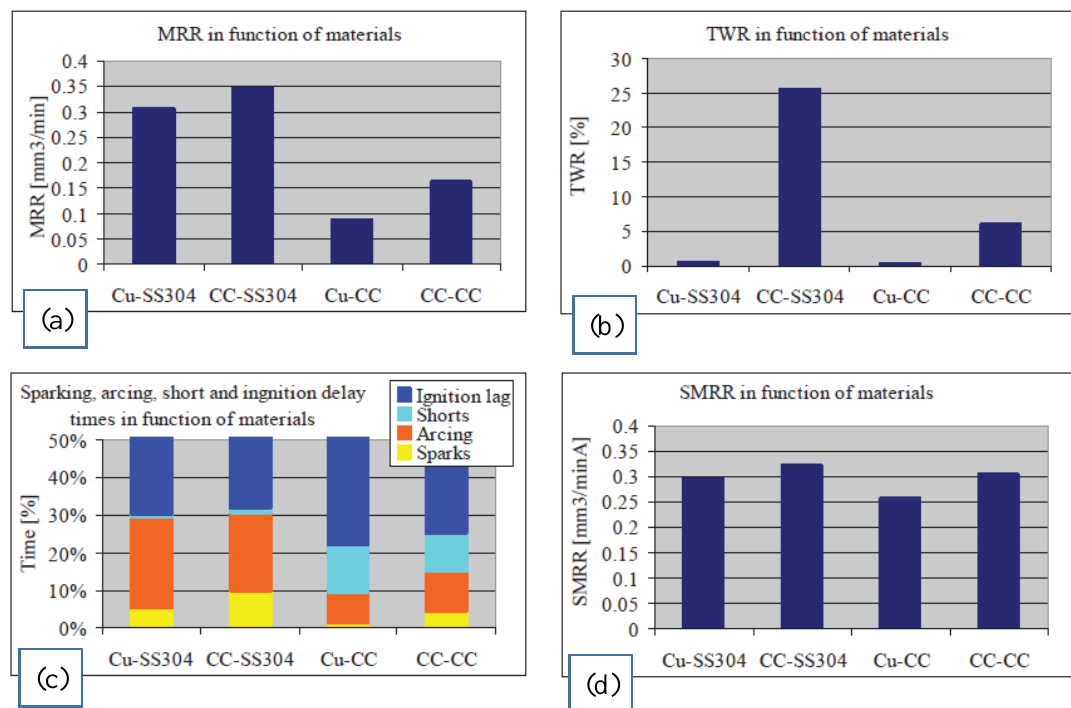
Figure 10. ( a ) MRR dependence on anode and cathode material combinations; ( b ) TWR as a function of anode and cathode material combinations; ( c ) sparking, arcing, shorts and ignition delay times as a function of anode and cathode material combinations; and ( d ) current specific MRR as a function of the anode and cathode material combinations [176].